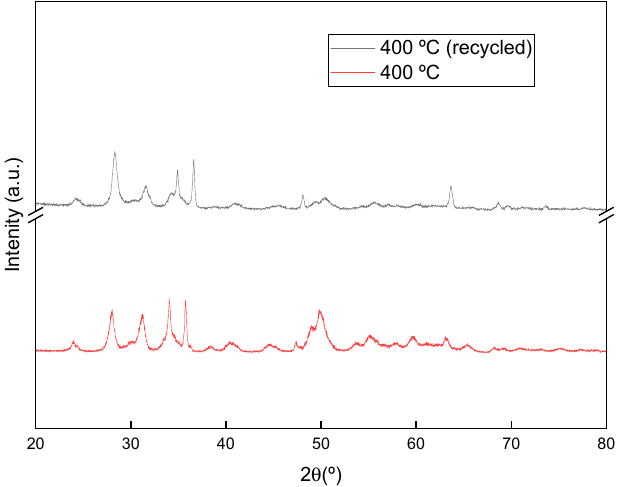
◦ C) before and after BA photocatalytic Figure 13. The XRD pattern of ZrO 2 NTs (400 ° C) before and after BA photocatalytic degradation. Figure 13. The XRD pattern of ZrO 2 NTs (400